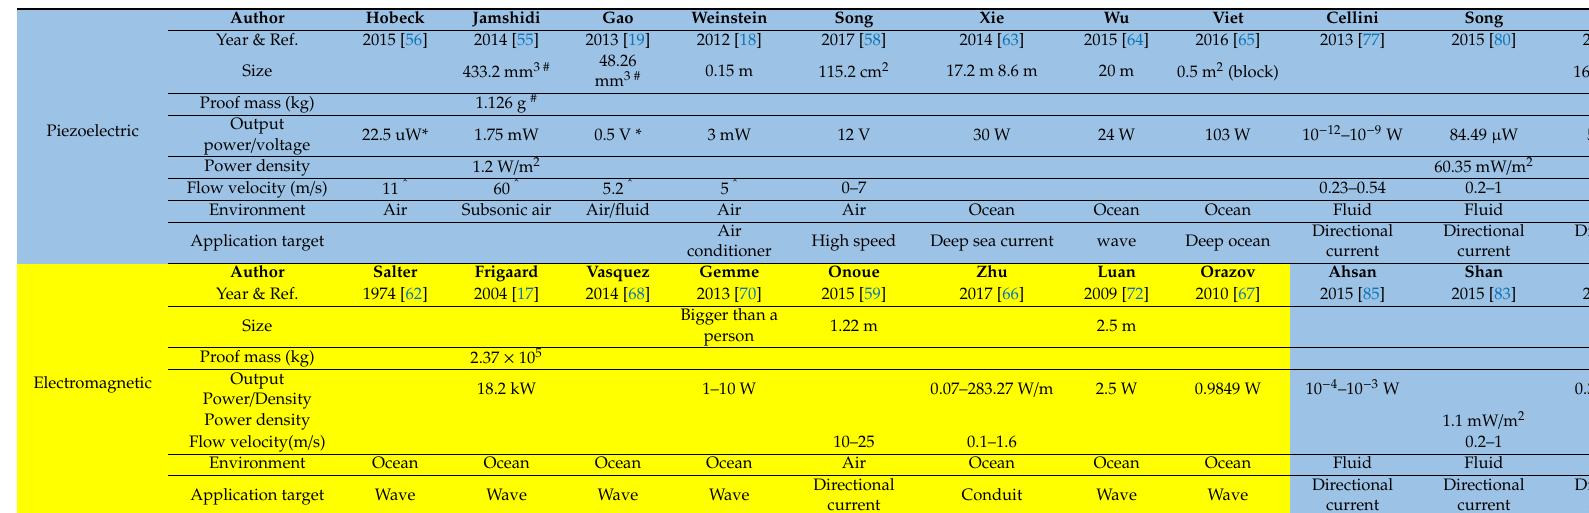
Table 1. Piezoelectric and electromagnetic energy